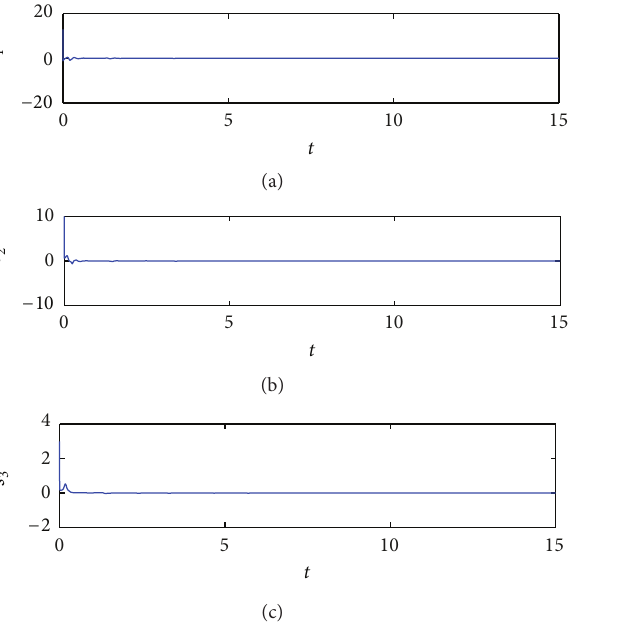
Figure 17: The trajectories of the adaptive laws of the parameter ̂𝜓 in Example